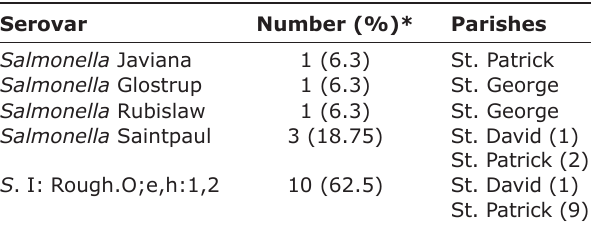
Table-2: Salmonella serovars from red-footed tortoises in Grenada.